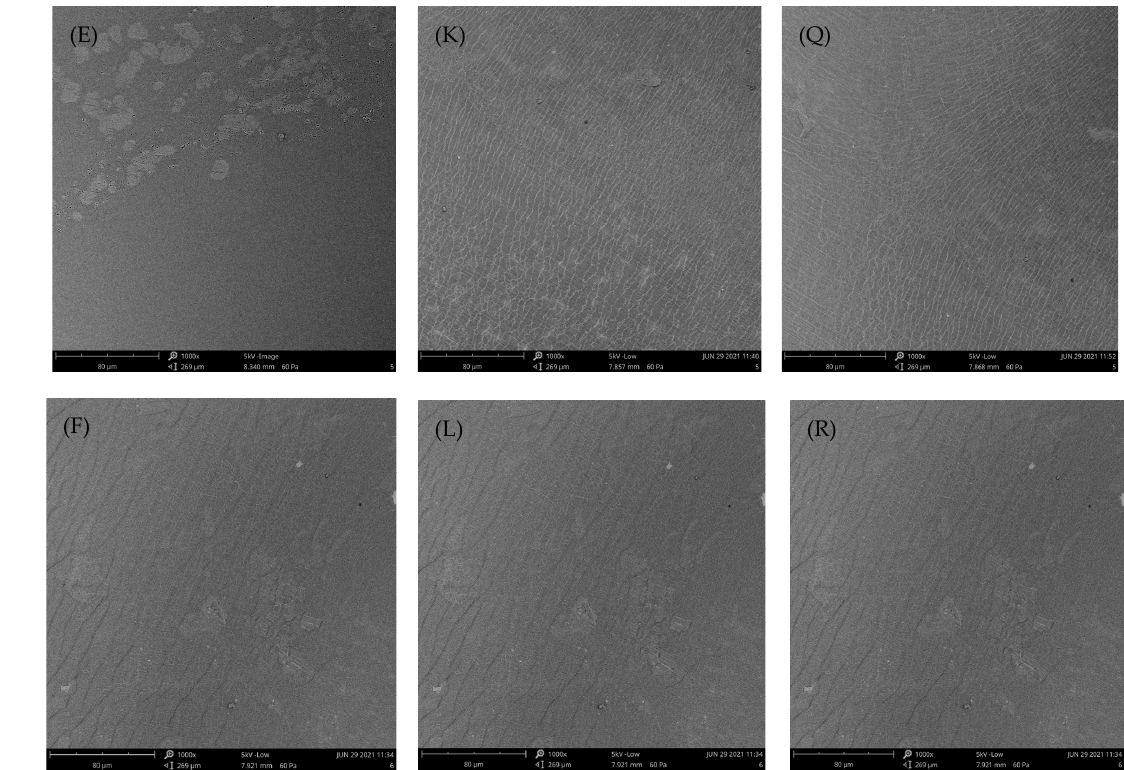
Figure 4. SEM images at 1000 × magnification of surface of the composite films containing commercial chitosan ( A – F ), untreated chitosan ( G – L ), or HHP chitosan ( M – R ) and gelatin in different